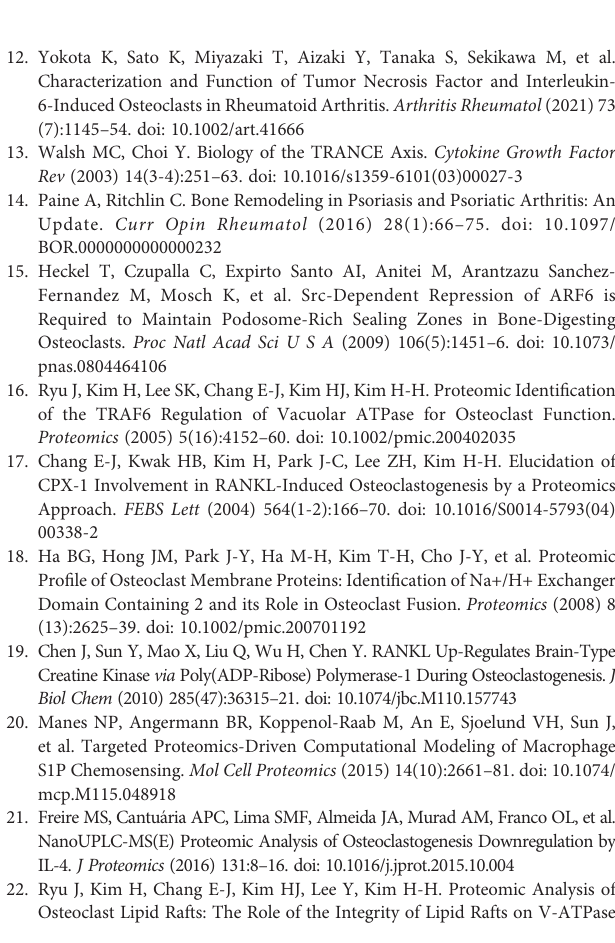
Supplementary Table 3 | GSE data. Table with data from Figure 3C and D . Supplementary Table 4 | GSE data. Proteins involved in monosaccharide metabolic process and defense response to bacterium pathways. Differential expression of osteoclasts and monocytes. Supplementary Table 5 | The biggest protein expression changes in osteoclasts. Table represents overexpressed or downregulated proteins (over 10 fold DE changes) in osteoclasts compared to monocytes. Supplementary Table 6 | GSE data. Table with data from Figures 7A – D